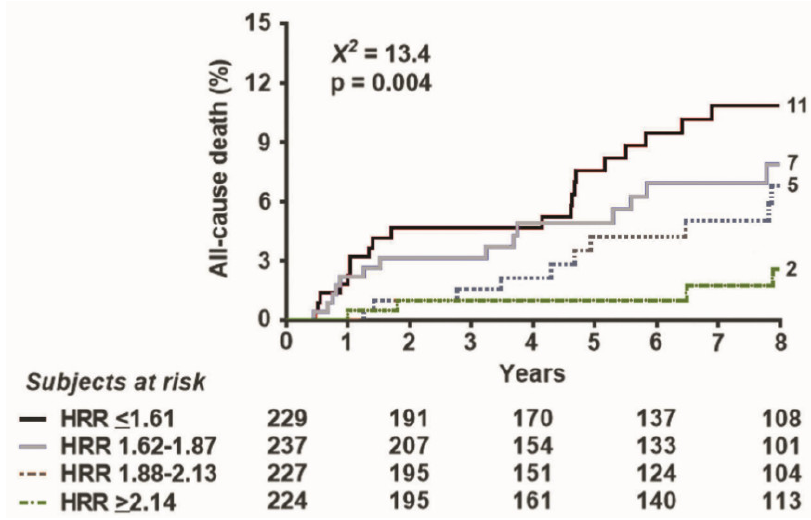
Figure 2. Survival curves based on HRR. Survival improves with higher values of (split in 4 quartiles). Table 4. Univariate and multivariate predictors of all-cause death. At multivariable analysis, lowest quartile HRR (Hazard ratio 2.354, 95% CI 1.116– 4.968, p = 0.025), and RWMA (Hazard ratio 3.279, 95% CI 1.441–7.461 p = 0.004) inde- Univariate Analysis Multivariate pendently predicted death, in addition to age (Hazard ratio 1.064, 95% CI 1.043–1.085, p < 0.001) and maximal wall thickness (Hazard ratio 1.081, 95% CI 1.037–1.128 , p < 0.001).